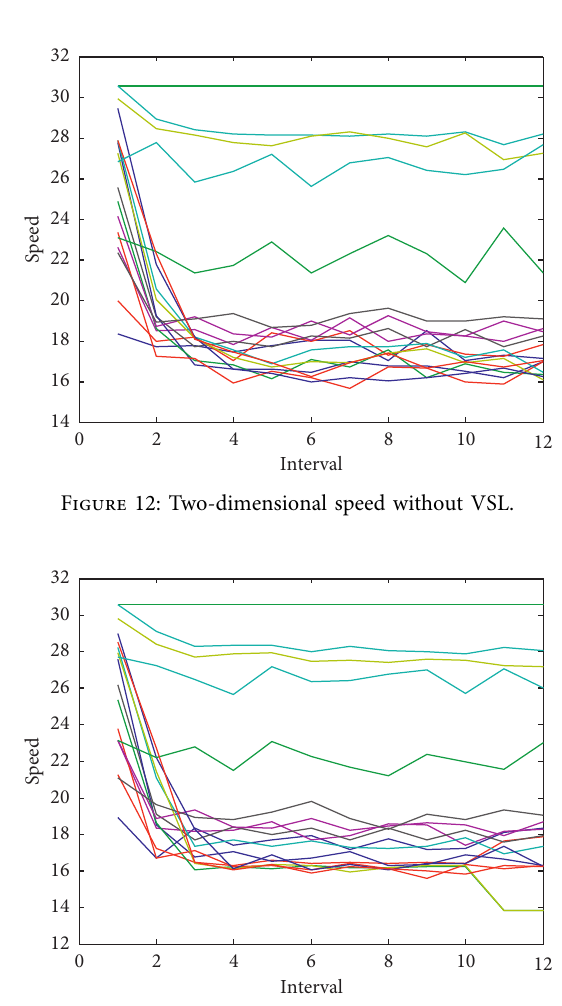
Figure 13: Two-dimensional speed with VSL.